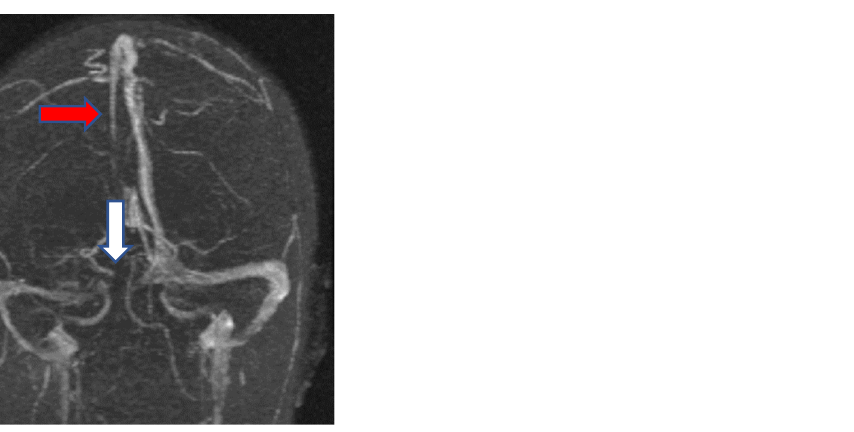
Figure 3. MR-venography 2D-TOF (2D-time of flight) in the coronal plane noting the absence of the flow in the superior sagittal sinus (red arrow) and the right lateral sinus (white arrow) with thrombosis of both sinuses at the onset.